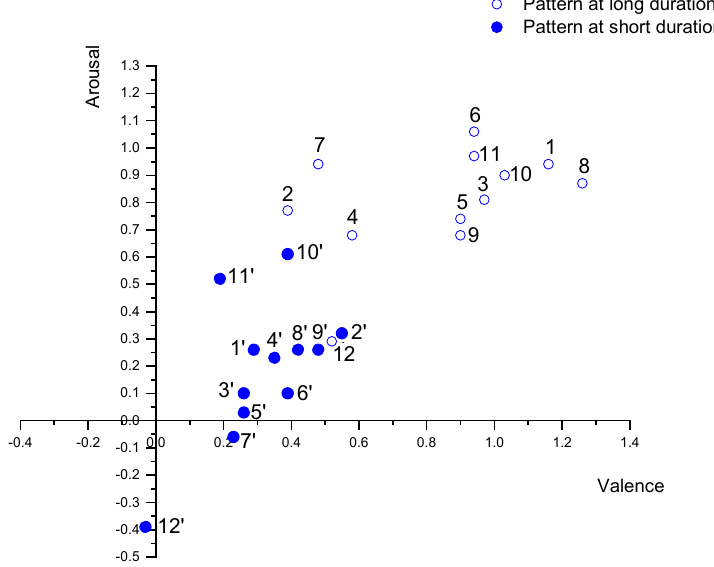
Figure 8. Emotional response due to change in duration at cold dynamic temperature. The apostrophe is used to distinguish the same pattern at different states of duration similar to Figure 7.